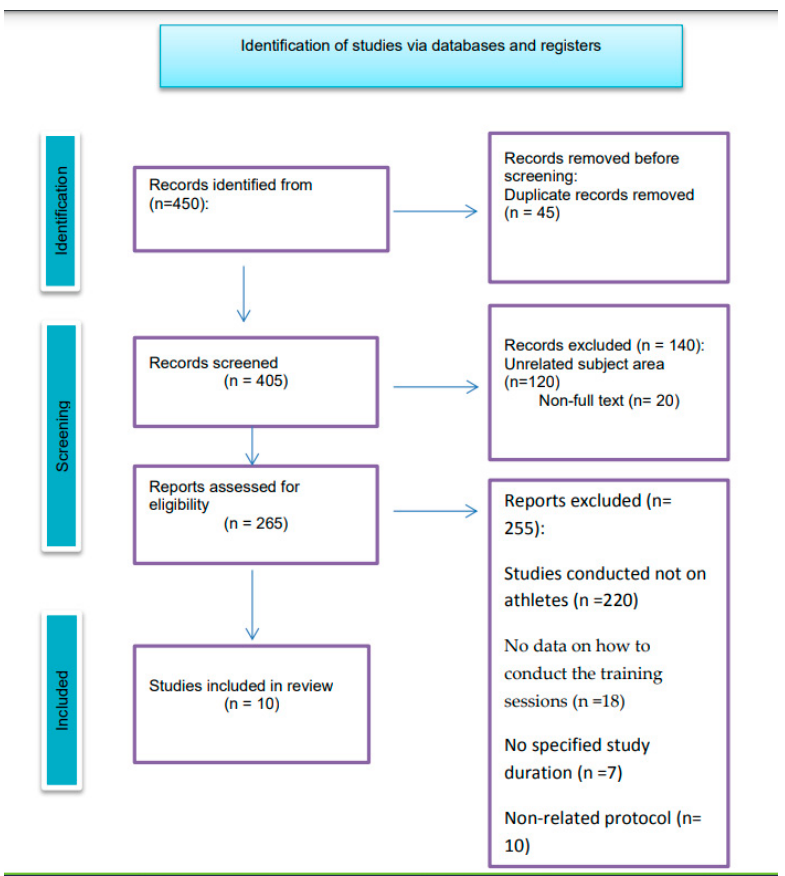
Figure 2. PRISMA chart for included studies.